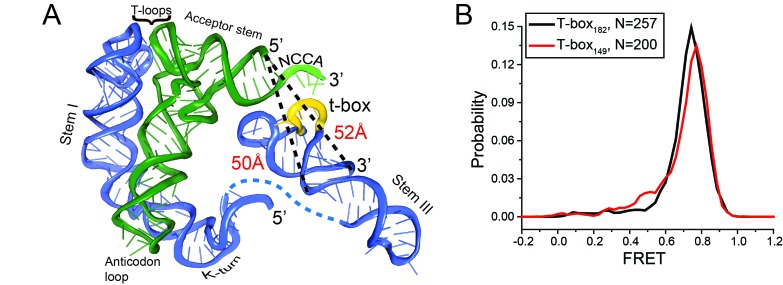
Intra-T-box FRET of T-box182 and T-box149.(A) Ribbon diagram of a complex of the B. subtilis glyQS T-box riboswitch and uncharged tRNAGly (Chetnani and Mondragón, 2017). Distances from the 5’ end of the tRNA to the 3’ end of the anti-terminator (T-box182) and to the 3’ end of Stem III (T-box149) are marked. (B) One dimensional FRET histograms of intra-T-box pair of T-box182 (black) and T-box149 (red) with Cy3 attached directly to the 3’ end of the T-box and Cy5 attached to the oligo hybridized to the 5’ extension of the T-box. Only the first 50 data points of the FRET trajectories are used to plot the histogram to eliminate the zero FRET resulting from Cy5 photobleaching. ‘N’ denotes the total number of traces in each histogram from two independent experiments.10.7554/eLife.39518.010Figure 2—figure supplement 3—source data 1.Cy3 and Cy5 intensity traces from two repeats for intra-T-box182 FRET in the absence of tRNA.10.7554/eLife.39518.011Figure 2—figure supplement 3—source data 2.Cy3 and Cy5 intensity traces from two repeats for intra-T-box149 FRET in the absence of tRNA.